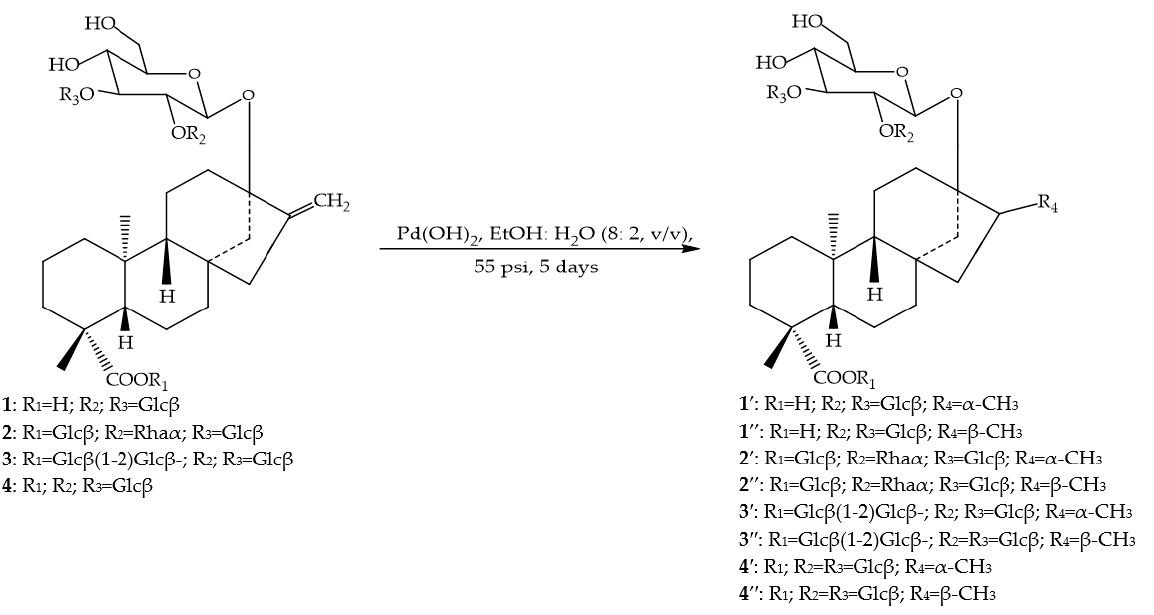
Figure 2. Catalytic hydrogenation of the exocyclic double bond in some steviol glycosides. Some diterpene glycoside compounds have been prepared from rebaudiosides A, B, C and D using different catalysts and reaction conditions [43,44]. The organoleptic prop- erties of the mixture of the reduced α -CH 3 and β -CH 3 diterpene glycoside isomers have